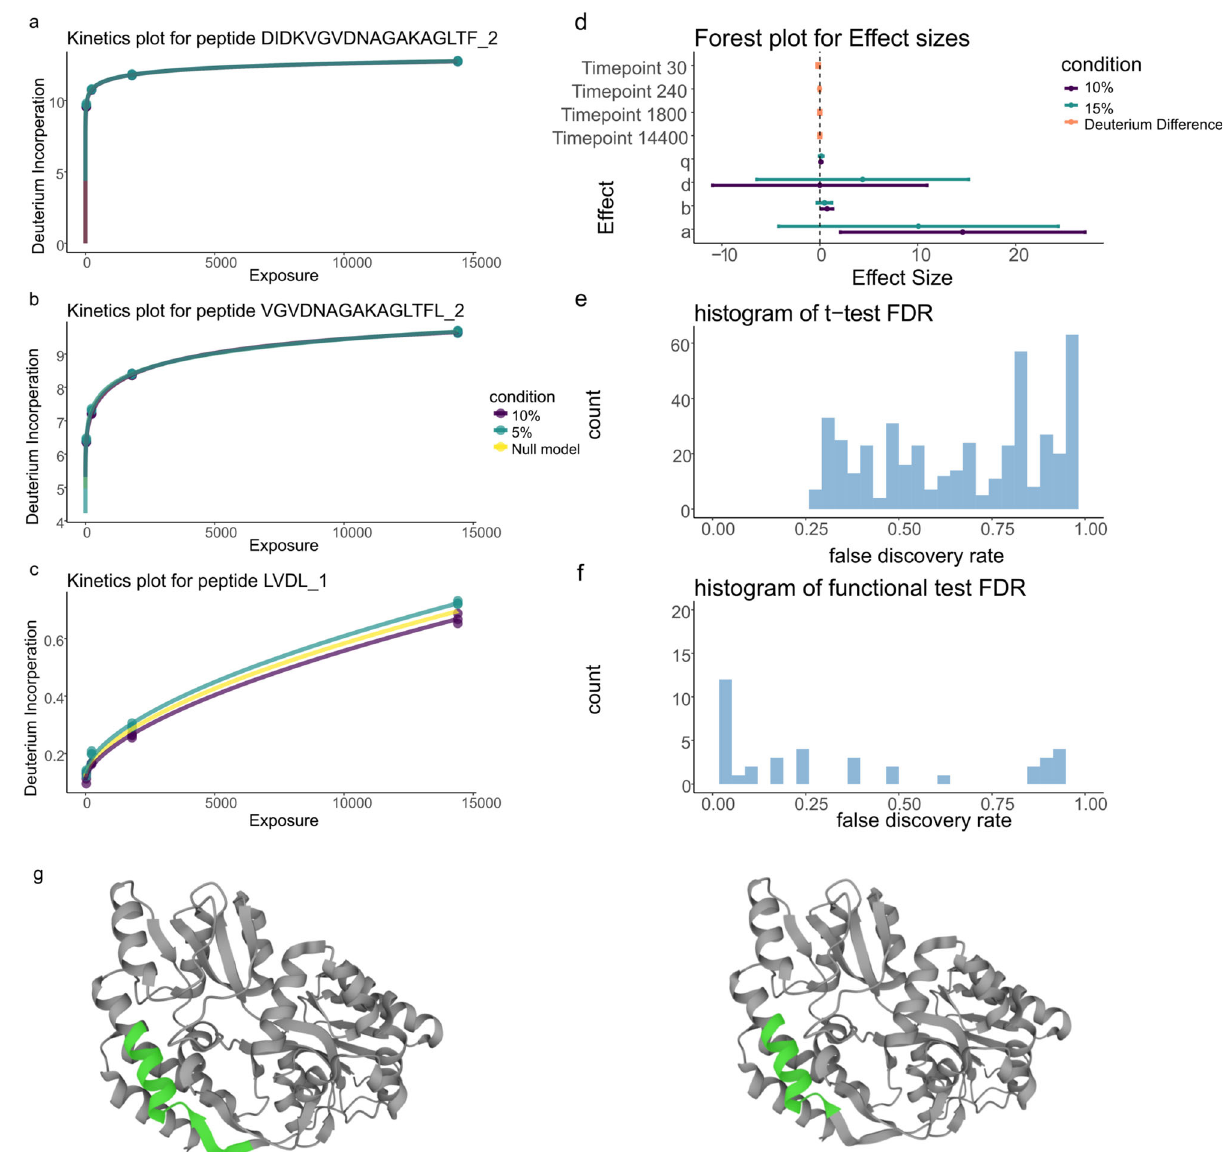
Fig. 4 Functional models can identify subtle, consistent differences. a Deuterium kinetics for peptide DIKDVGVDNAGAKAKAGLTF [203-220] in charge state 3. Deuterium incorporation is plotted against solvent exposure time in seconds. Conditions are coloured with the null model in yellow. The number after the underscore indicates the charge state. ( b ) same as for ( a ) but for peptide VGVDNAGAKAGLTFL [207 – 220] in charge state 2. ( c ) as for ( a ) but for peptide LVDL [221 – 224] in charge state 1 ( d ) Forest plot for effect sizes corresponding to peptide in ( a ). e , f Histogram of adusted p -values for the t test and functional method, correspondingly. g MBP (PDB: 1OMP) with DIKDVGVDNAGAKAKAGLTF (left) and VGVDNAGAKAGLTFL (right) highlighted in